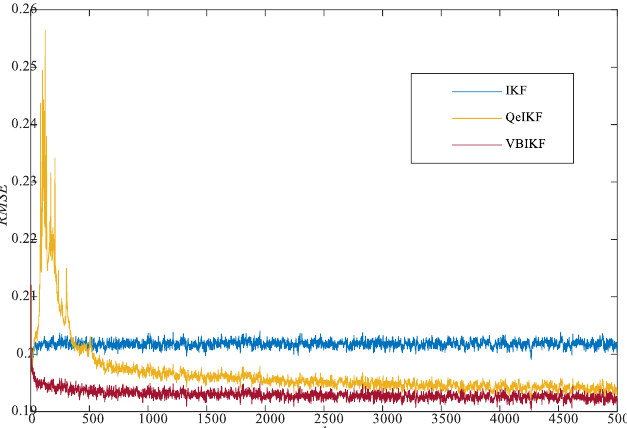
Figure 5. The Figure 5. The RMSE k result of the IKF, the QeIKF, and the VBIKF for the scaled ˆ Σ w with α = 6.